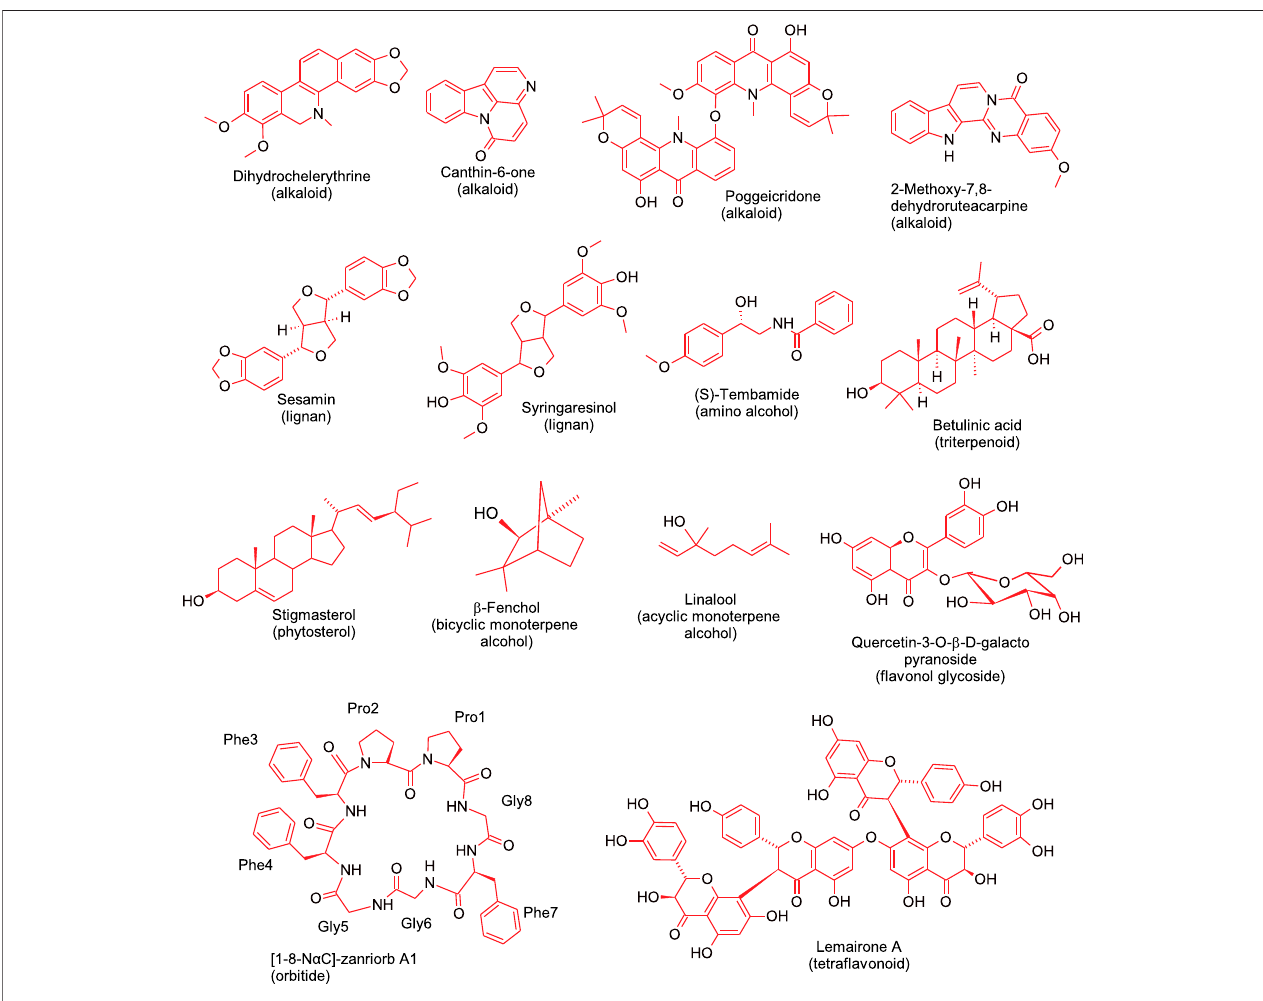
FIGURE 2 | Representative bioactive compounds, from different phytochemical classes, isolated from Zanthoxylum species.